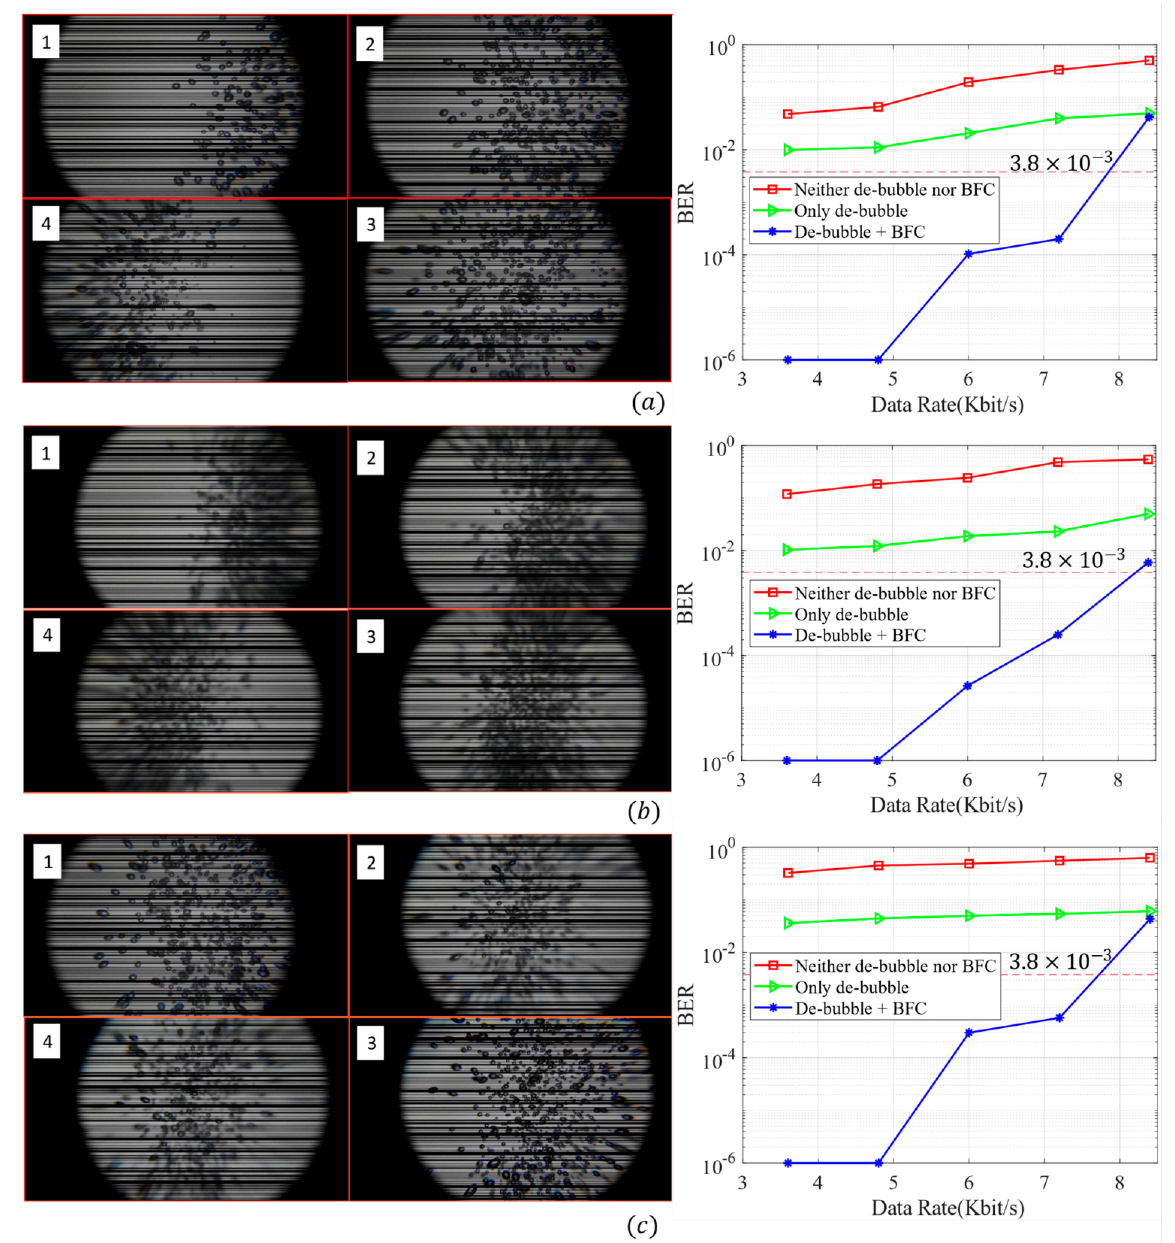
Figure 13. BER performances in a dense bubble moving scene: ( a ) K = 5 and the bubble source moves left and right in the image, ( b ) K = 10 and the bubble source moves left and right in the image, ( c ) the air pump is located in the center of the image and K varies from 5 to